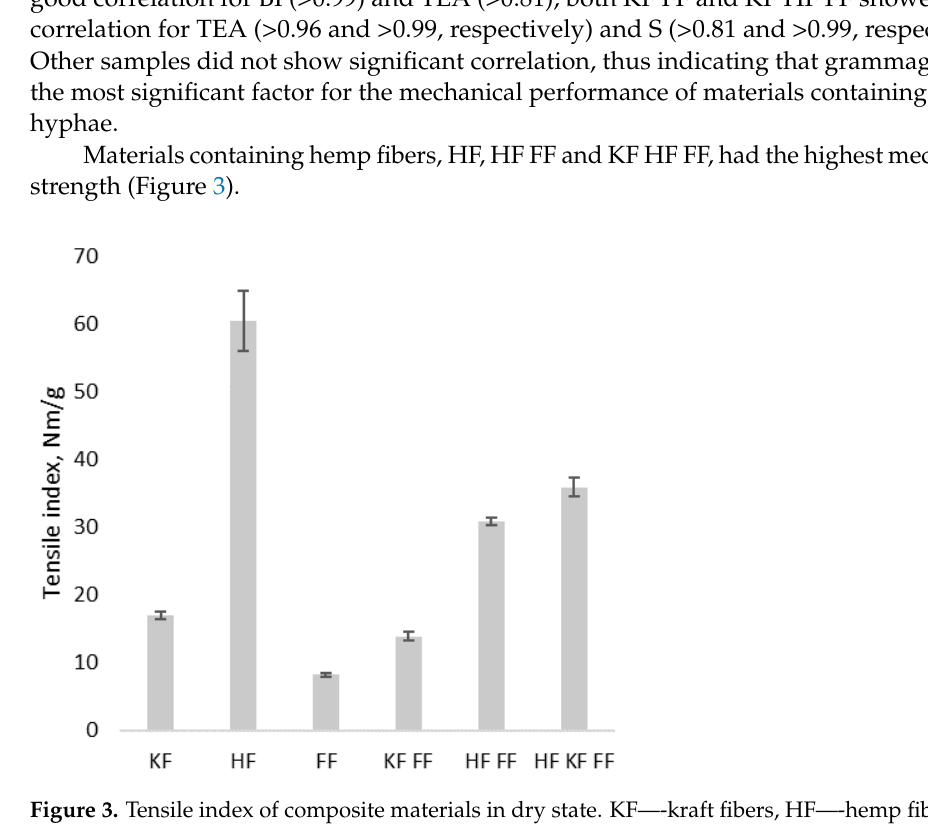
Figure 3. Tensile index of composite materials in dry state. KF—-kraft fibers, HF—-hemp fibers, and FF—-fungus fibers.